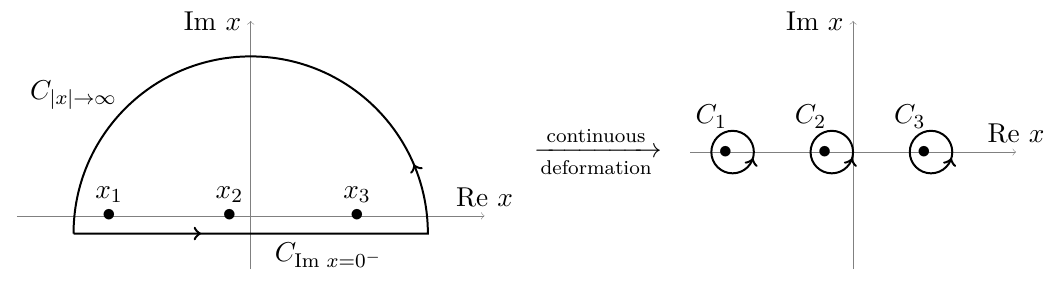
Figure 1 . ‘theta’ prescription in 1 + 1 D